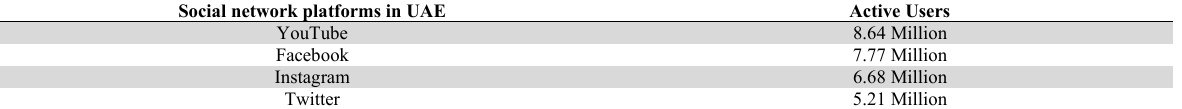
Active users Social network platforms in